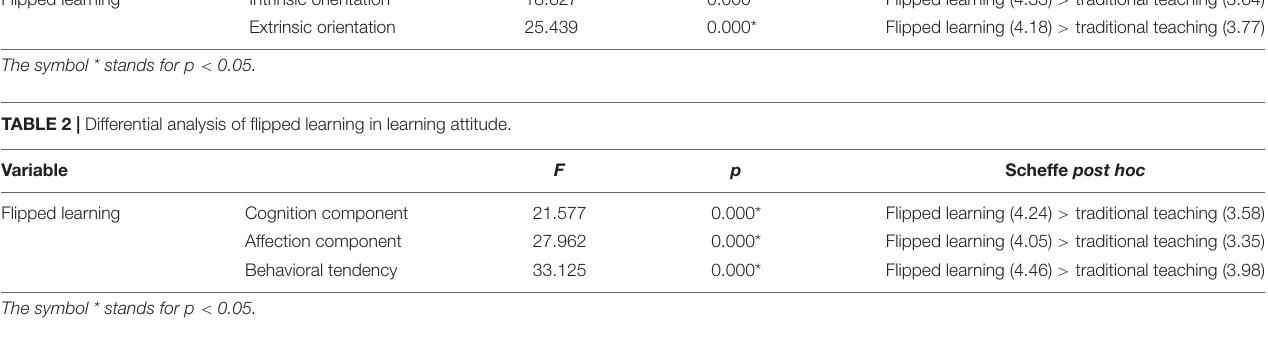
TABLE 3 | Relationship between learning motivation and learning